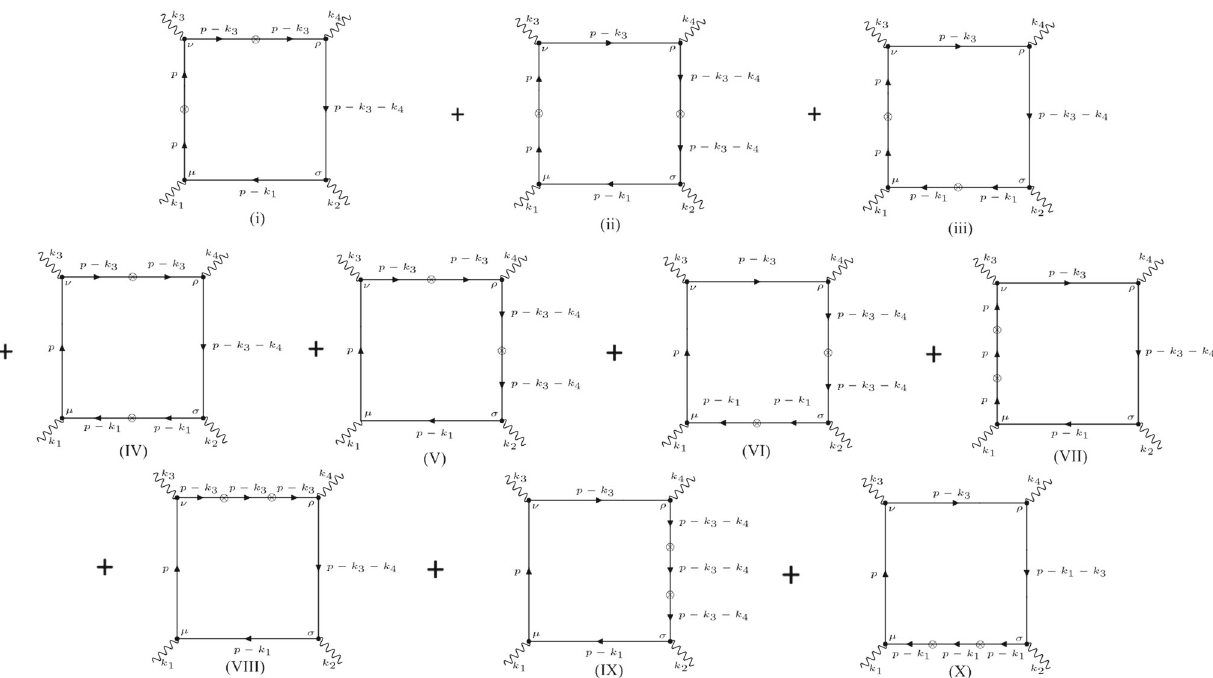
Fig. 2 Contribution of the fourth order in the external fields, with two insertions of / b γ